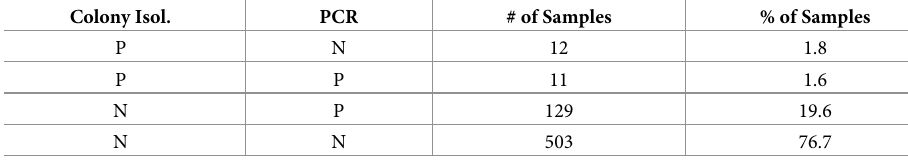
Table 4. Number of positive or negative samples for B . glumae using two detection methods. Colony